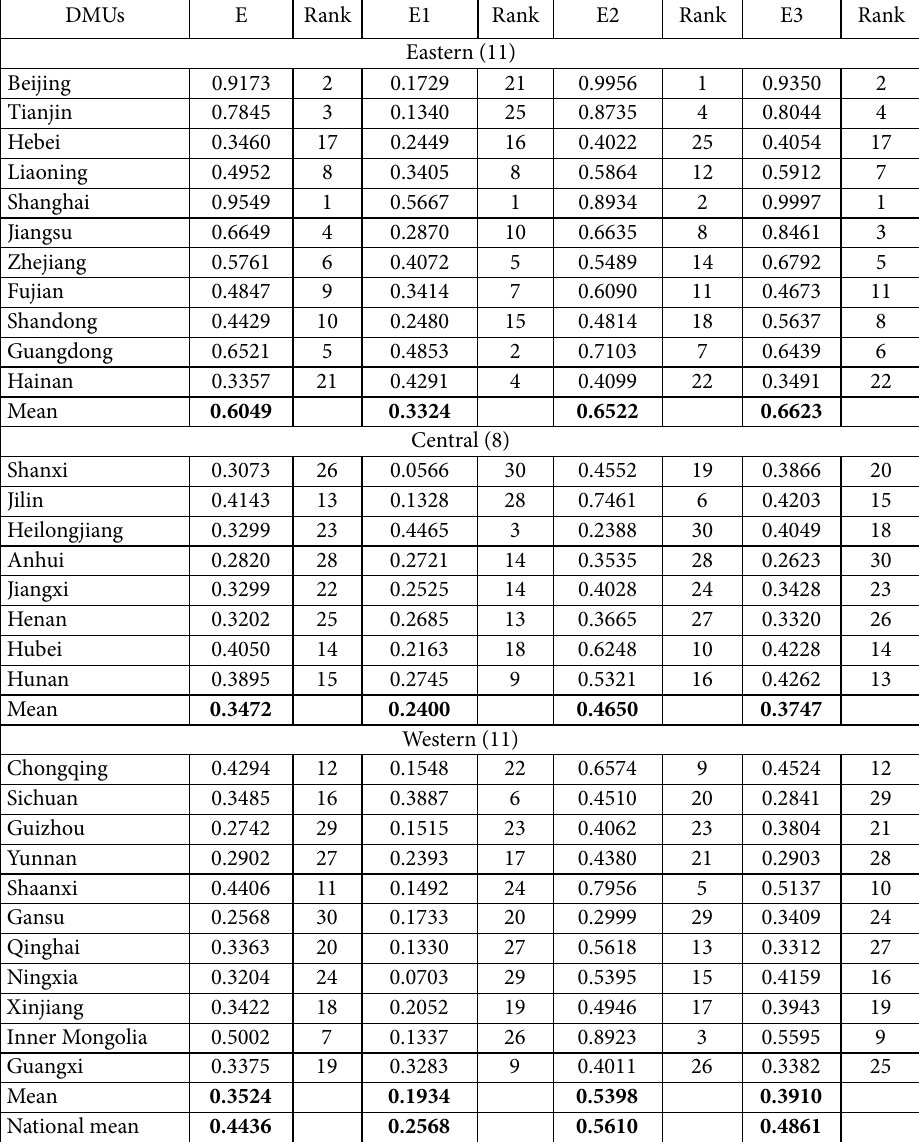
Table 2. Mean value and ranking of environmental